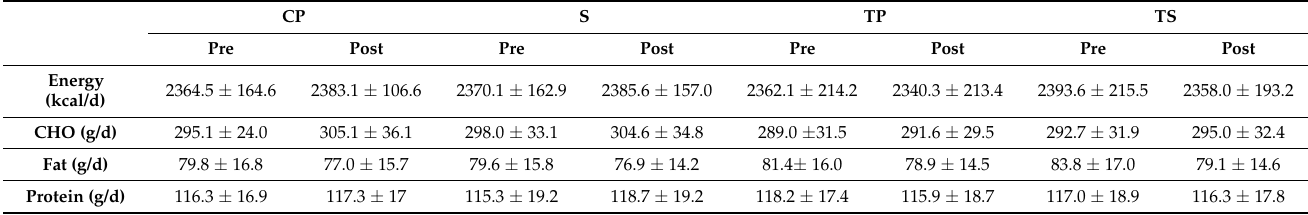
Table 2. Mean ± SD values of nutritional intake in the four study